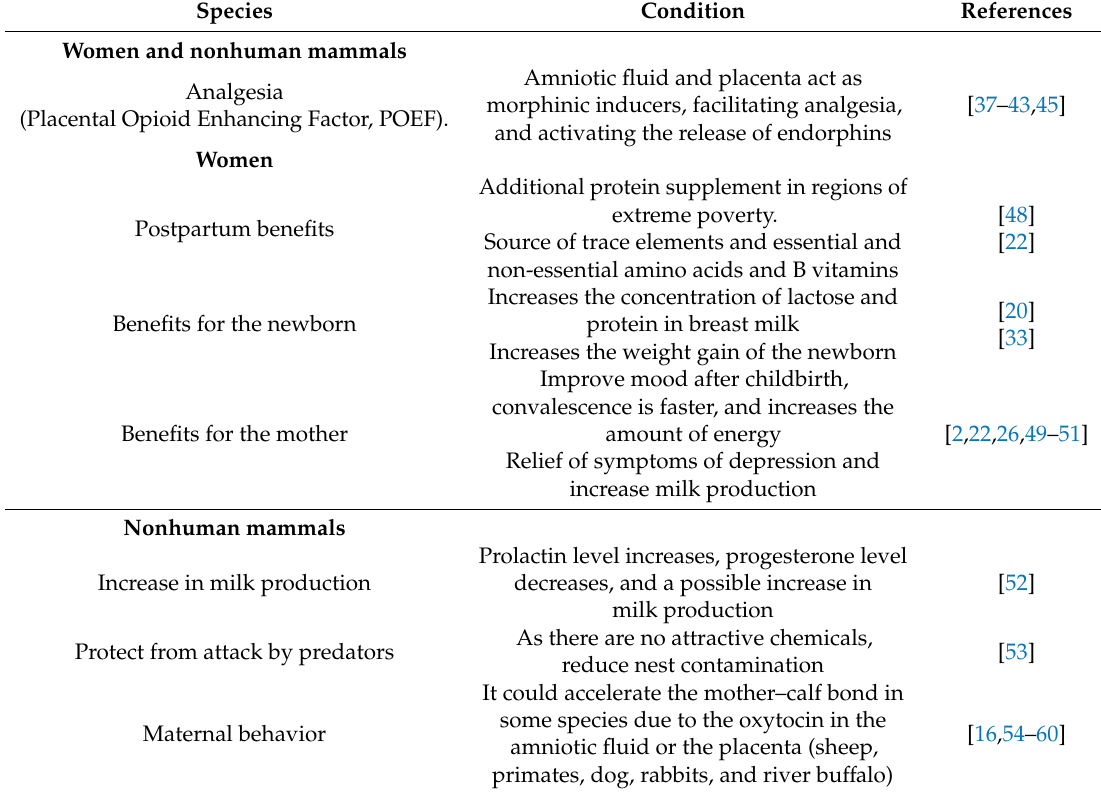
Table 1. Potential advantages of placentophagia in women and nonhuman